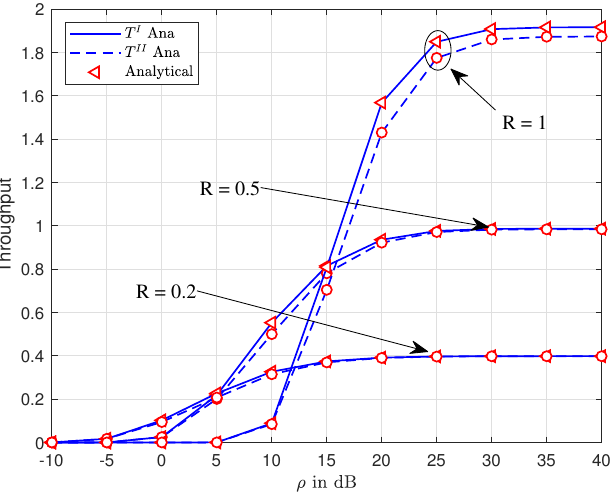
Figure 9. Throughput of system versus ¯ ρ S with varying the target rate R 1 = R 2